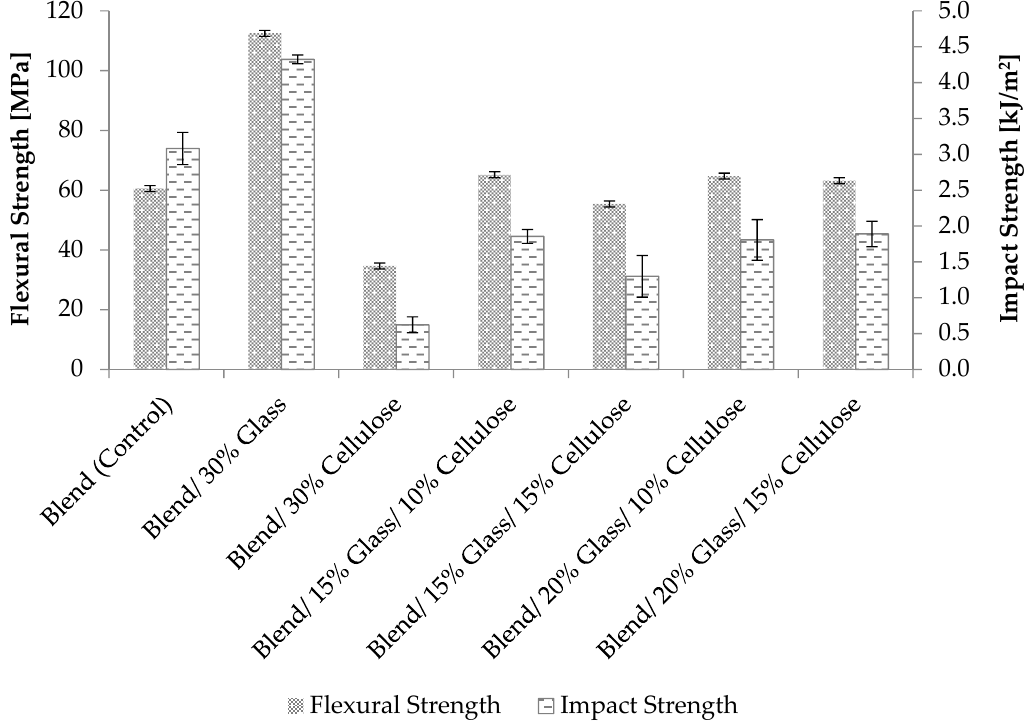
Figure 2. Flexural and impact strength of unfilled polymer blends and cellulose and glass fiber reinforced composites.